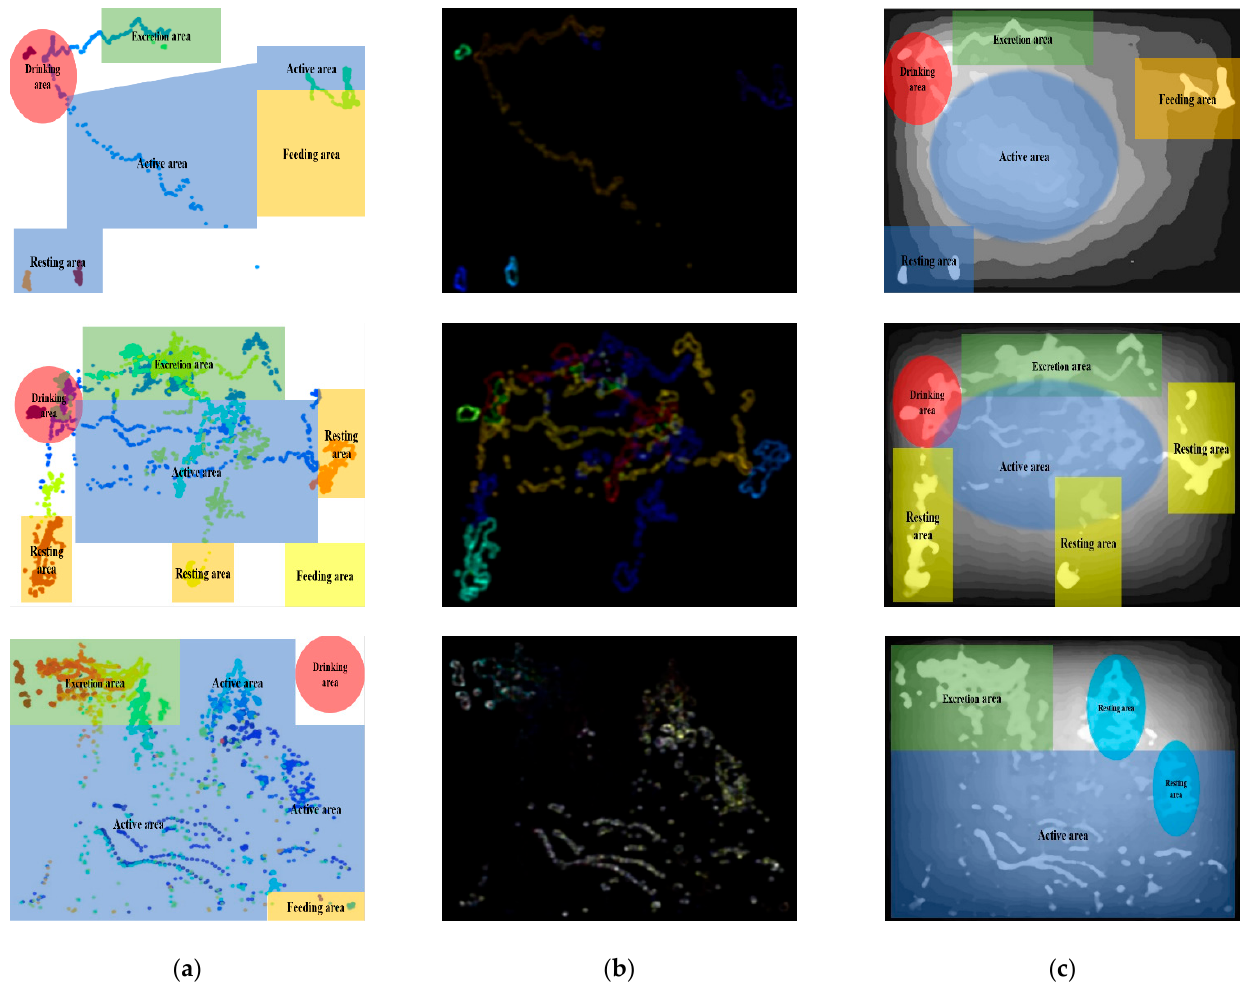
Figure 14. Active area analysis. ( a ) Active areas; ( b ) random center surrounding saliency; ( c ) dual-channel map.